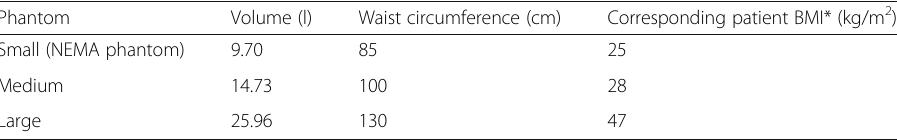
Table 2 Phantom sizes and corresponding patient characteristics